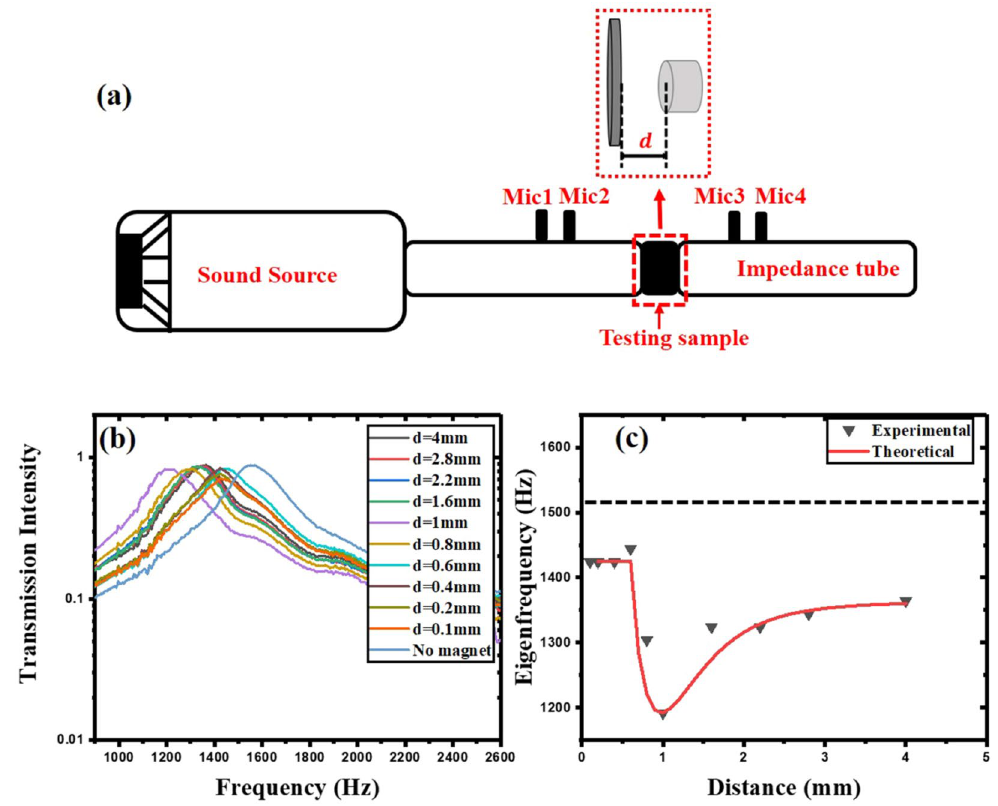
Figure 3. ( a ) Experimental set-up. The test sample (magnetic membrane and magnet installed on aluminum fixture) is placed into the impedance tube. ( b ) The transmission intensity spectrum of the diaphragm when the position of the magnet is adjusted differently away from the membrane. ( c ) The shift of the eigenfrequency of the membrane when the magnet is at different distances (the black dotted line is the initial fundamental eigenfrequency of the magnetic